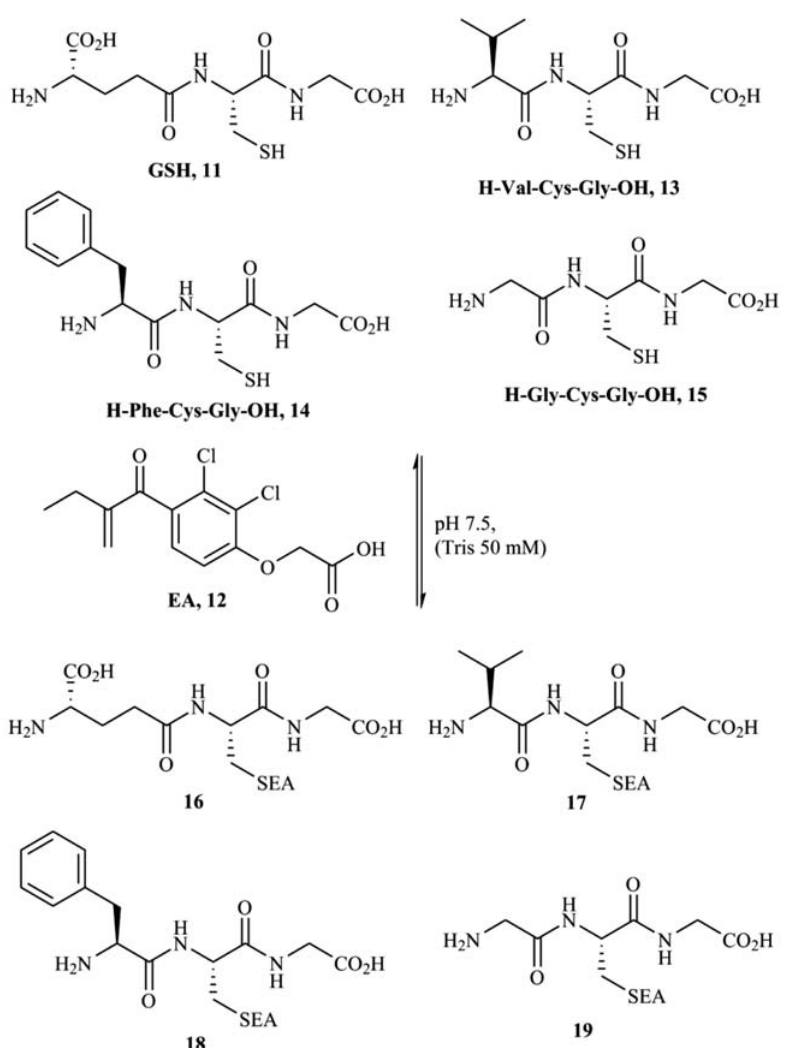
Figure 4. Dynamic combinatorial library composed of glutathione (GSH) conjugates potentially capable of binding to glutathione S-transferase (GST) generated from GSH, GSH analogues, and ethacrynic acid (EA).